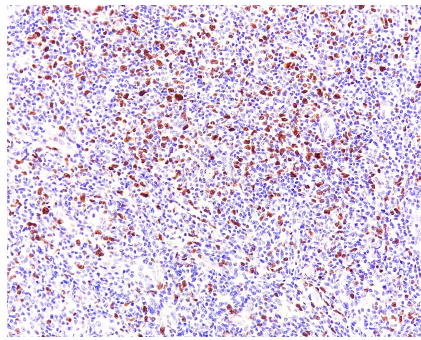
Figure 9. Ki67 staining. Magnification 200×.